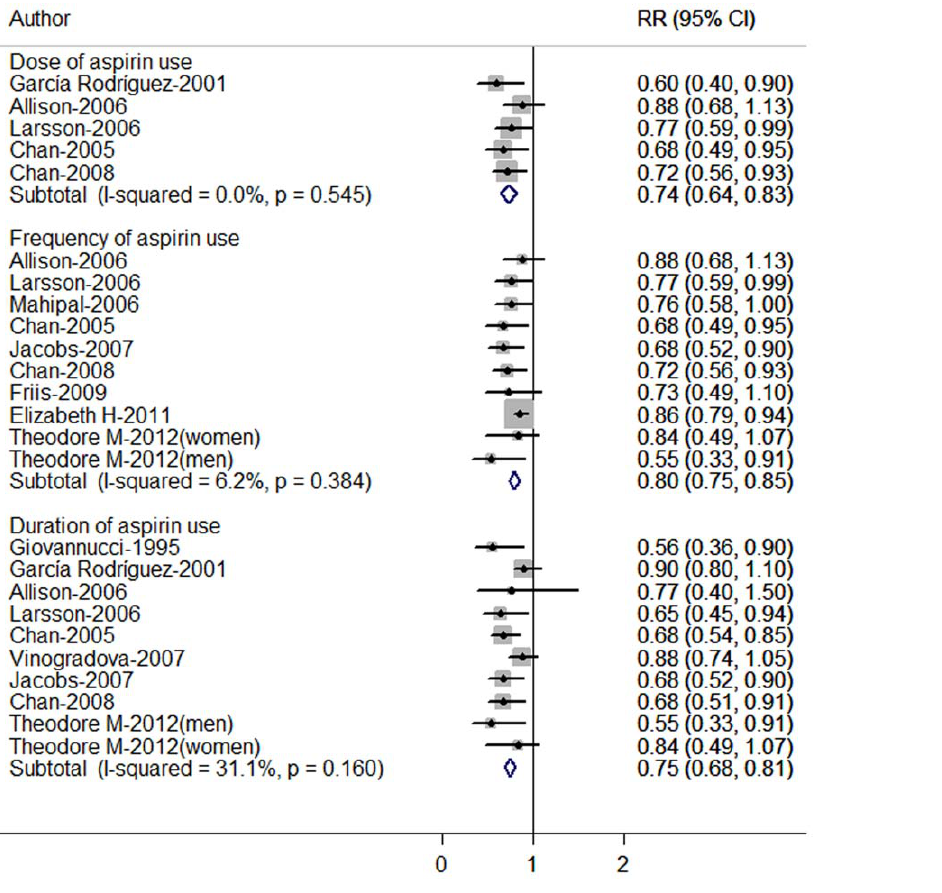
Figure 1. Relative risk of colorectal cancer for highest vs lowest categories of aspirin use (dose, frequency and duration). The combined relative risk was achieved using fixed-effects model. Grey square represents relative risk in each study, with square size reflecting the study- specific weight and the 95% CI represented by horizontal bars. The diamond indicates summary risk estimate.